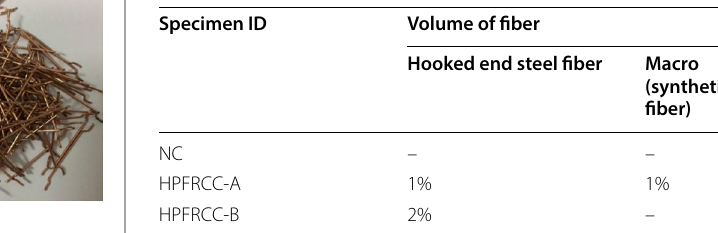
Table 3 The type of used